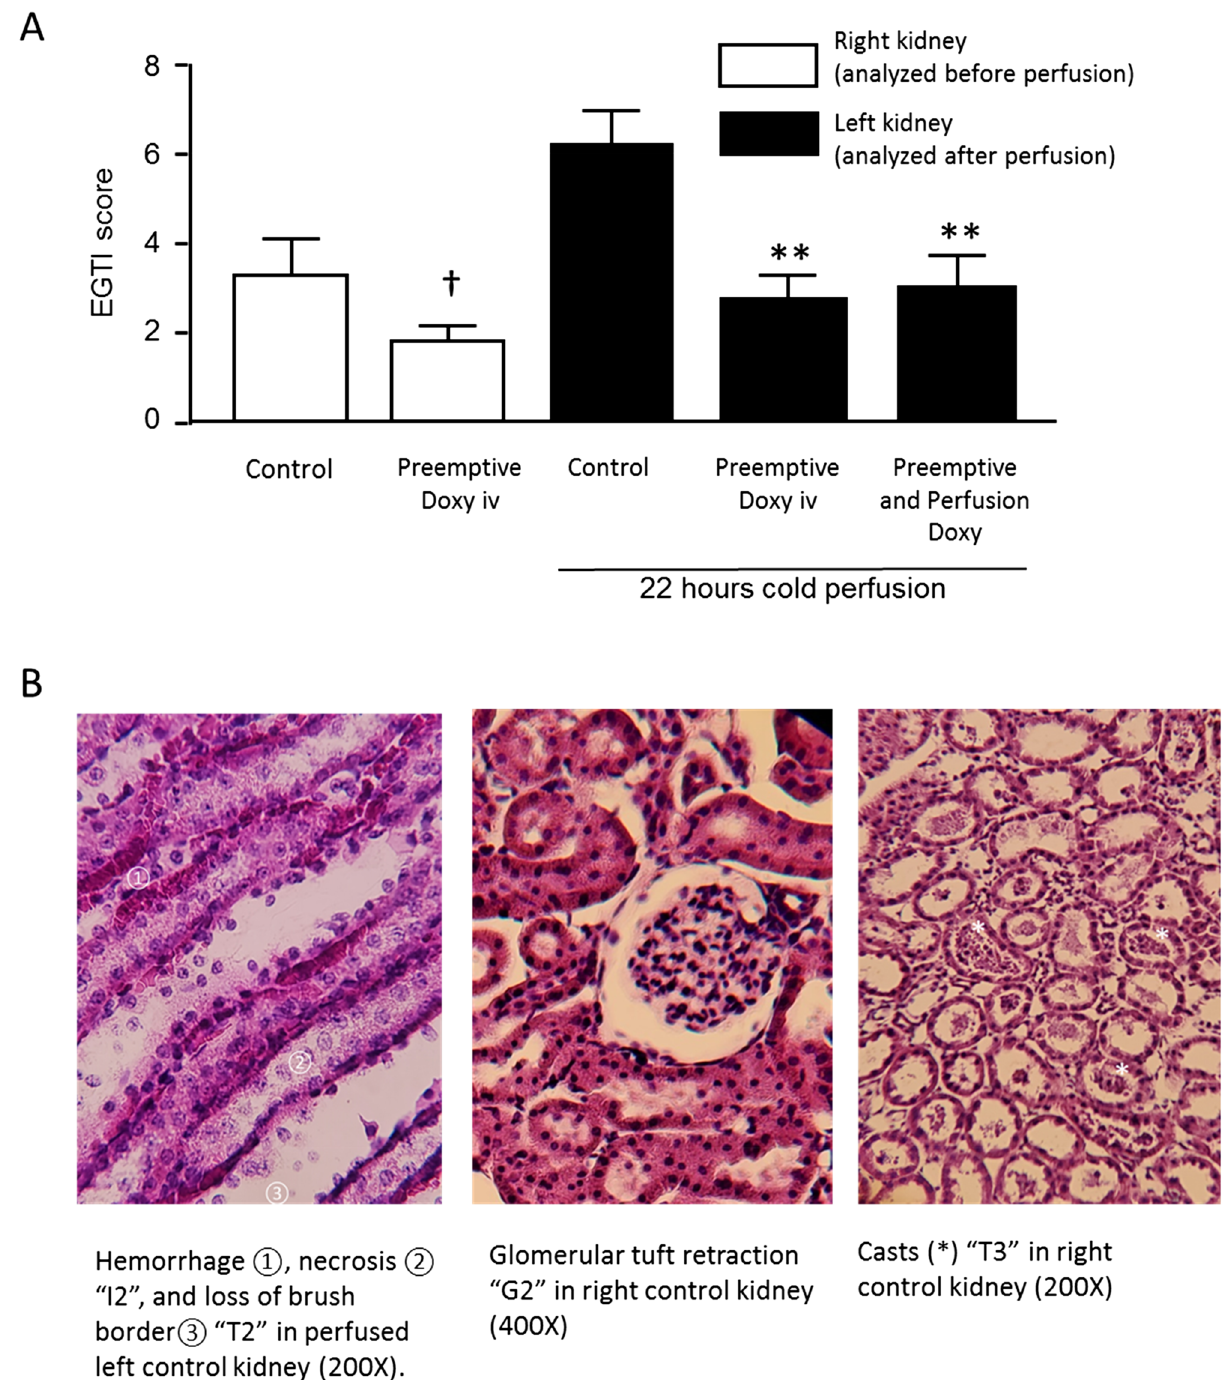
Figure 4. ( A ) Histological injury as measured by the EGTI (Endothelial, Glomerular, Tubular, and Interstitial) score of Khalid et al. * p < 0.01 compared to the right kidney (Warm Ischemia) Control Group, using the Mann– Whitney U test. † p = 0.105 compared to the left kidney (Warm and Cold Ischemia) Control Group, using the Mann–Whitney U test. ( B ) Examples of EGTI